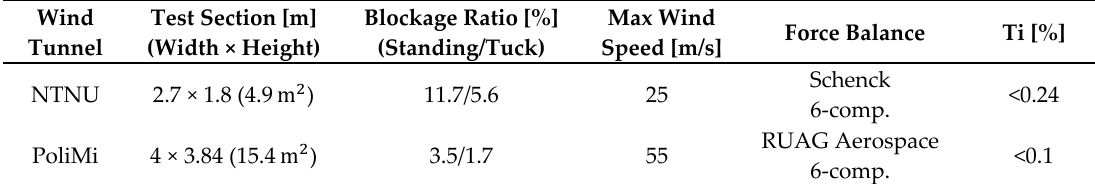
Table 1. Main characteristics of the wind tunnel, turbulence intensity (Ti) and blockage ratios for the experiments at the Norwegian University of Science and Technology and at the Politecnico di Milano.